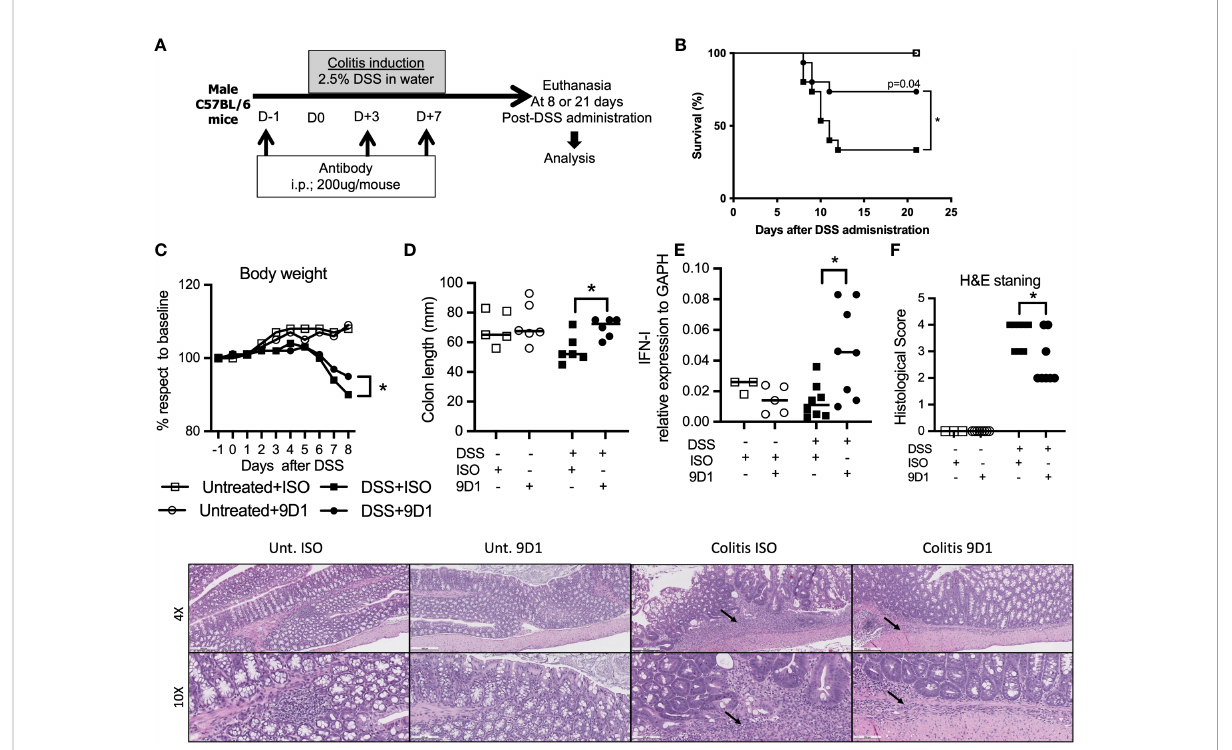
FIGURE 5 Treatment with anti-RGMb antibody 9D1 prevents in fl ammatory bowel disease. (A) To assess the capacity of anti-RGMb antibody treatment to prevent colitis, mice were injected with anti-RGMb mAb 9D1 or Isotype control antibody (12.5 mg/Kg; i.p.). 24h after fi rst injection mice were treated or not with 2.5% DSS in their drinking water for 7 days to induce colitis. Mice were euthanized at day 8 or 21. (B) Mice survival was monitored for 21 days after DSS administration. (C) Mice body weight changes during the induction of colitis. Statistical signi fi cance of the weight changes on day 8 was determined using the Student ’ s test. (D) Gross morphological changes and (E) IFN-I expression in gut of the colon on day 8 after 7 days of 2.5% DSS and 1-day drinking water. (F) Gut histopathology was performed by H&E staining on controls versus control isotype antibody- and 9D1-treated mice at 8 days after DSS administration (n=8/group). Histology is shown at 4x (scale bar 500 m m) and 10x (scale bar 200 m m). Small arrows represent in fl ammatory in fi ltrate. Results are expressed as mean ± SEM (n ≥ 3/group). * p ≤ 0.05. One-way ANOVA comparisons.